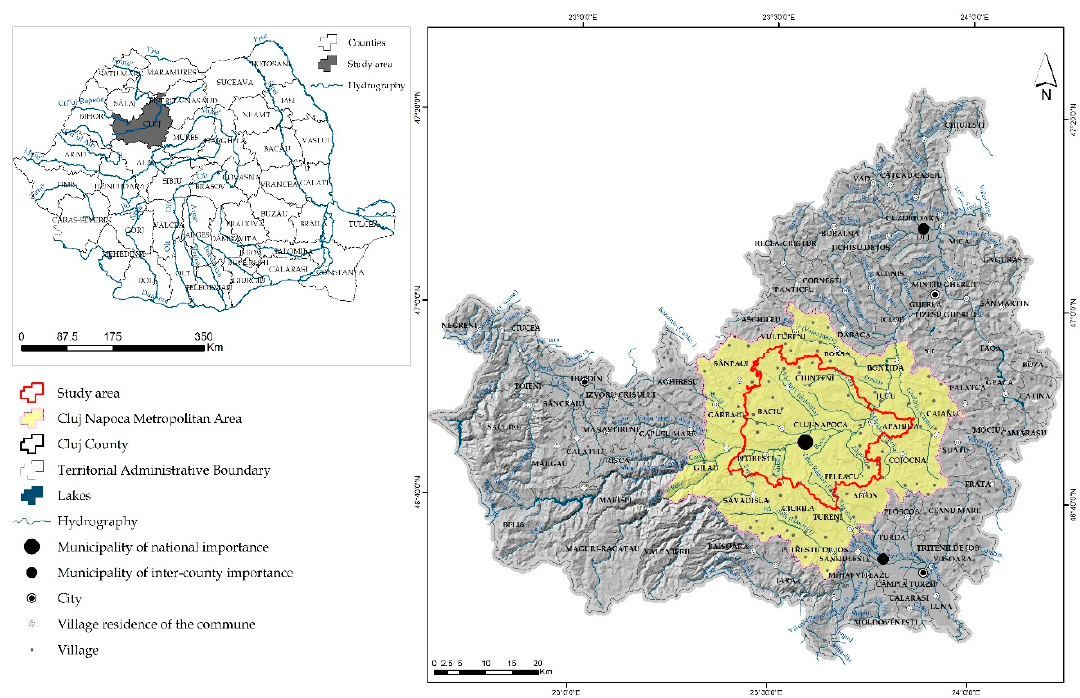
Figure 1. Geographic location of the study area.